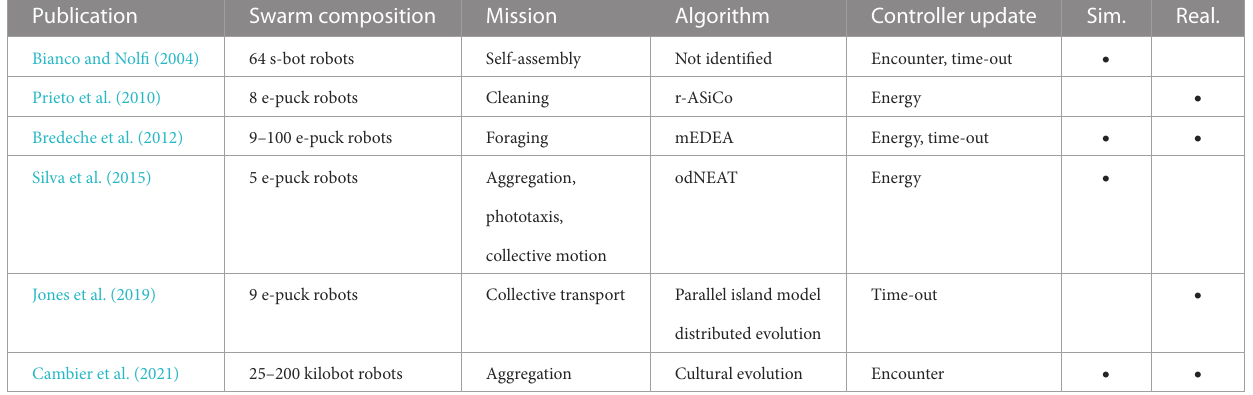
TABLE5 Overviewofselectedembodiedevolutionresearchinswarmrobotics.